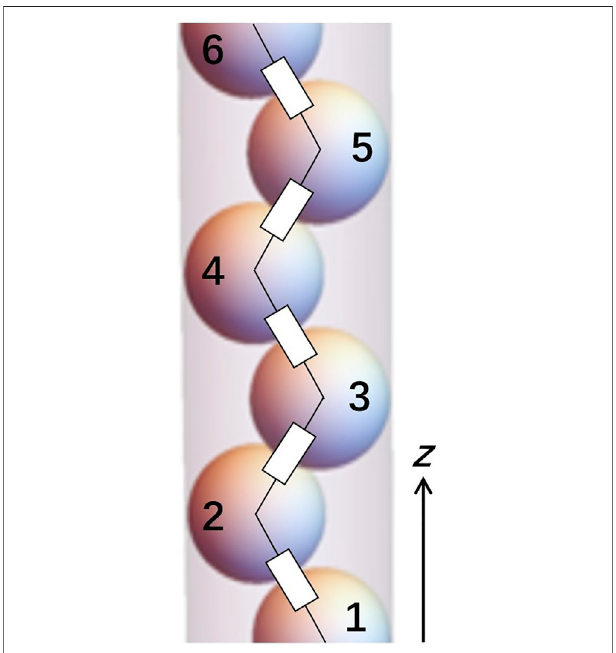
FIGURE 2 | Schematic illustration of a zigzag structure at (cid:1)(cid:1) √ D ∈ ( 1 , 1 + 3 /2 ) and the corresponding zigzag chain of resistors. For any pair of touching spheres, the inter-particle resistance R , which takes into account the bulk resistance of each sphere and the contact resistance between the spheres, is modelled by a resistor that joins the centres of the spheres. The diameter of the con fi ning cylindrical tube is just equal to D , if the diameter of each sphere is taken to be unity. The spheres are indexed in ascending order of their vertical z -positions.